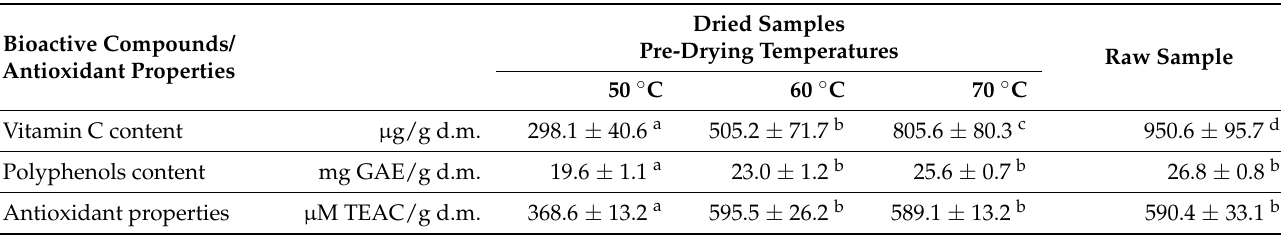
Table 3. Vitamin C, determined using HPLC method, and polyphenolic contents along with antioxidant properties, both determined by spectrophotometric method, in chokeberry powders prepared by the FBJD method with pre-drying fruit at temperatures of 50, 60, and 70 ◦